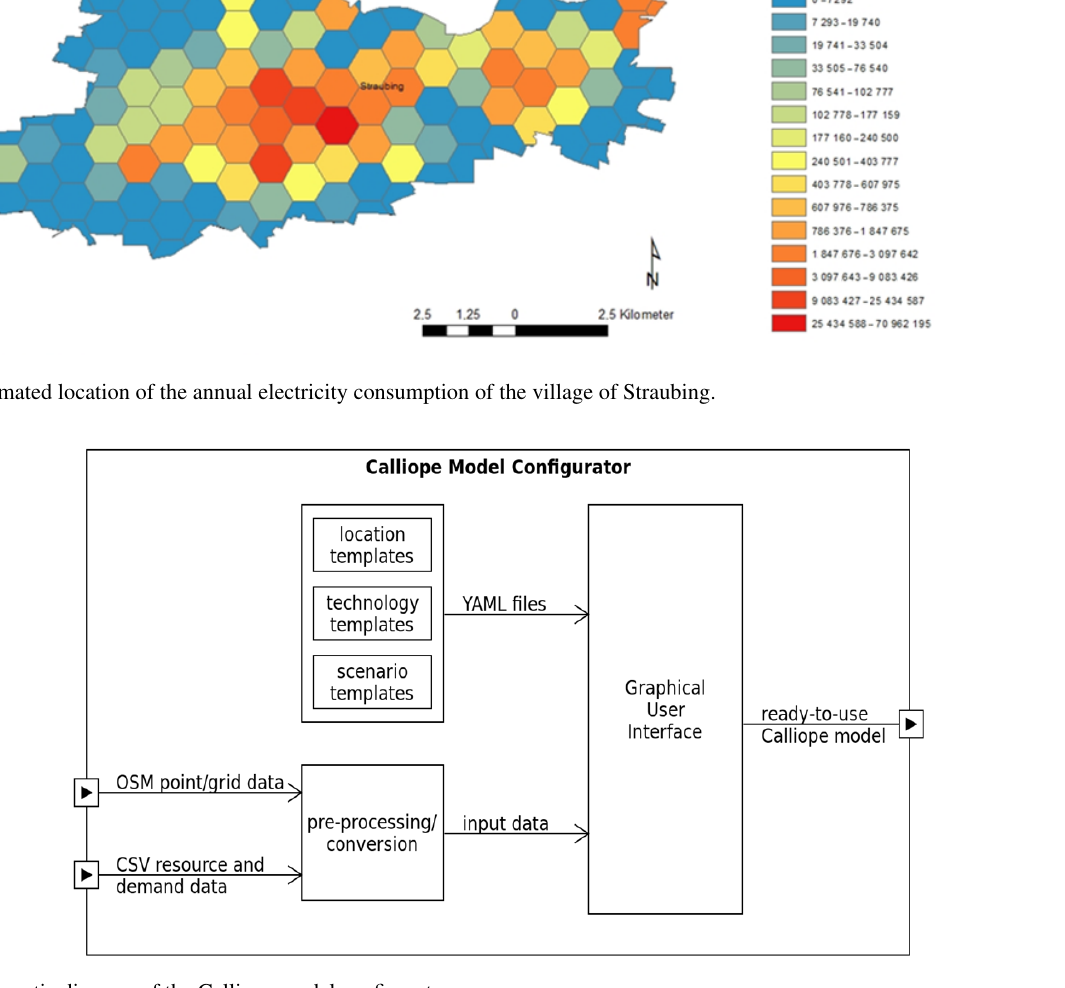
Figure 6. Schematic diagram of the Calliope model